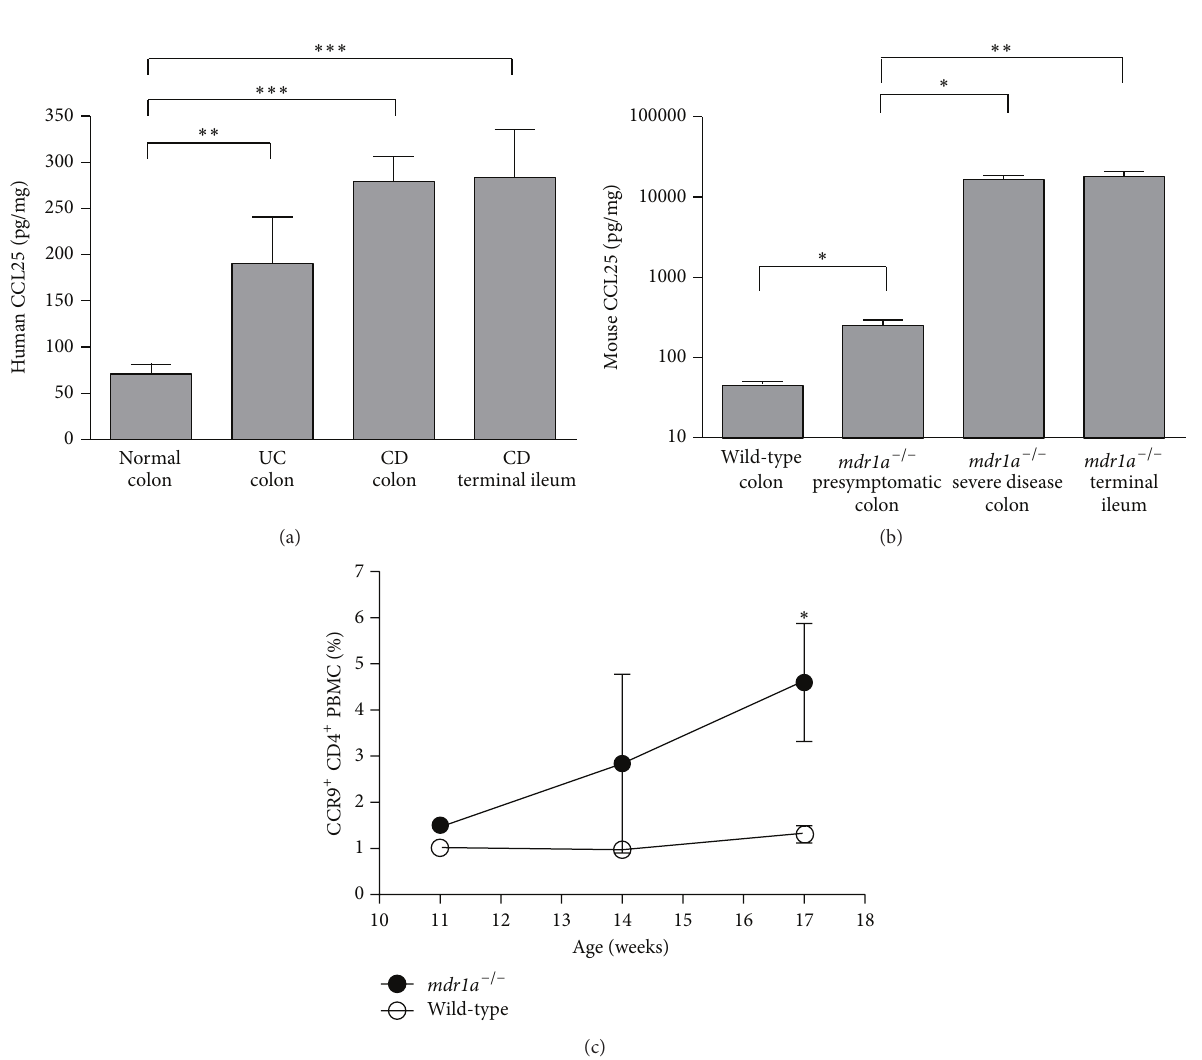
Figure 3: CCL25 protein levels are significantly elevated during colonic inflammation. CCL25 protein levels in homogenates of colon and terminal ileum were determined by ELISA and normalized to the levels of total protein. (a) CCL25 protein levels were significantly elevated in colon biopsies from individuals with active Crohn’s disease or ulcerative colitis, relative to healthy controls. In Crohn’s disease, the levels of CCL25inthecolonwereequivalenttothelevelsintheterminalileum. 𝑛 =6–8individuals.(b)CCL25levelswereincreasedinpresymptomatic mdr1a −/− mice and further increased in mdr1a −/− mice with severe disease, compared to wild-type mice. 𝑛 = 6–8 mice. (c) The frequency of CCR9 + CD4 + T cells among PBMC is significantly increased in mdr1a −/− mice compared to age-matched wild-type mice; 𝑛 = 5 mice per time point. ∗ 𝑃 < 0.05; ∗∗ 𝑃 <